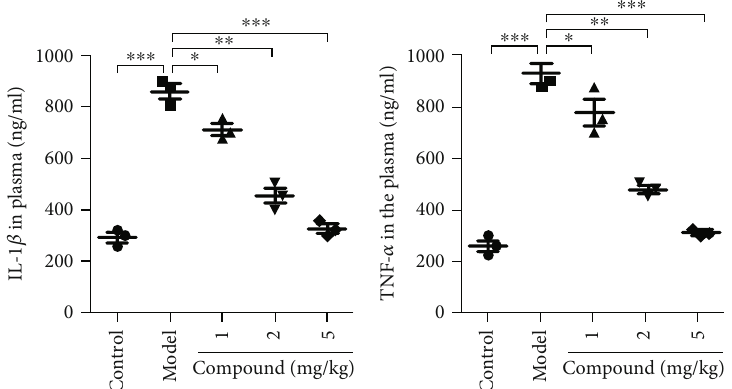
Figure 4: Compound signi fi cantly reduces the releasing of the IL-1 β and TNF- α into the plasma. 10 8 CFU Staphylococcus aureus was injected into the animal to induce the bacterial infection animal model; then, the compound was used for treatment at the concentration of 1, 2, and 5mg/kg. After the treatment, the plasma was harvested and the IL-1 β and TNF- α content released into plasma was measured through the ELISA detection